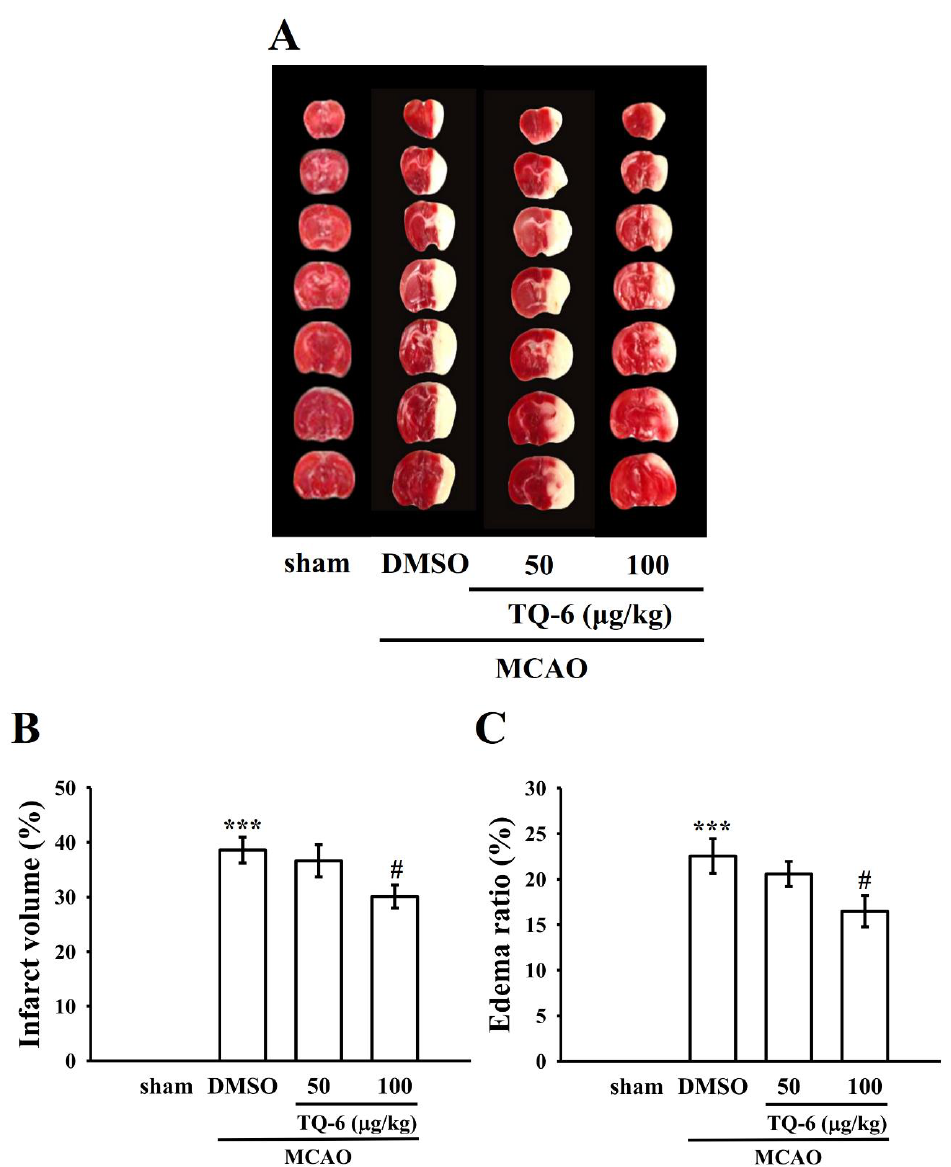
Figure 4. Protective effects of TQ-6 against cerebral ischemic stroke in mice. ( A ) Coronal sections of 2,3,5-triphenyltetrazolium chloride (TTC)-stained brains after middle cerebral artery occlusion (MCAO) in the sham operation group and the groups treated with either 0.1% DMSO or TQ-6 (50 and 100 μg/kg, intraperitoneal) for 30 min, followed by embolic occlusion, as described in the Materials and Methods section. Densitometric analysis for measuring the ( B ) infarct volume and ( C ) edema ratio after treatment with TQ-6 against embolic stroke in mice. Data are presented as mean ± SEM ( n = 8). *** p < 0.001 compared with the sham operation group; # p < 0.05 compared with the MCAO group. 3.5. TQ-6 Inhibited Aggregation and OH • Formation in Mice Platelets Platelets are involved in atherosclerotic plaque formation and are a cause of inflammatory reaction (i.e., free radicals), which may be a significant root of atherothrombosis [26]. Therefore, the